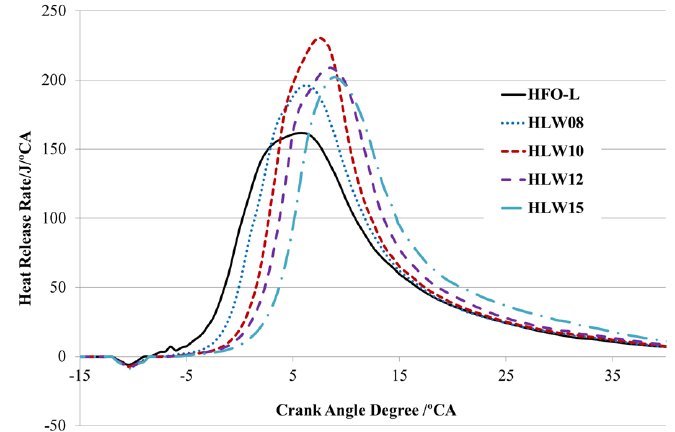
Figure 10. Comparison of the heat release rate curves of the cases fueled with four fuel blends.